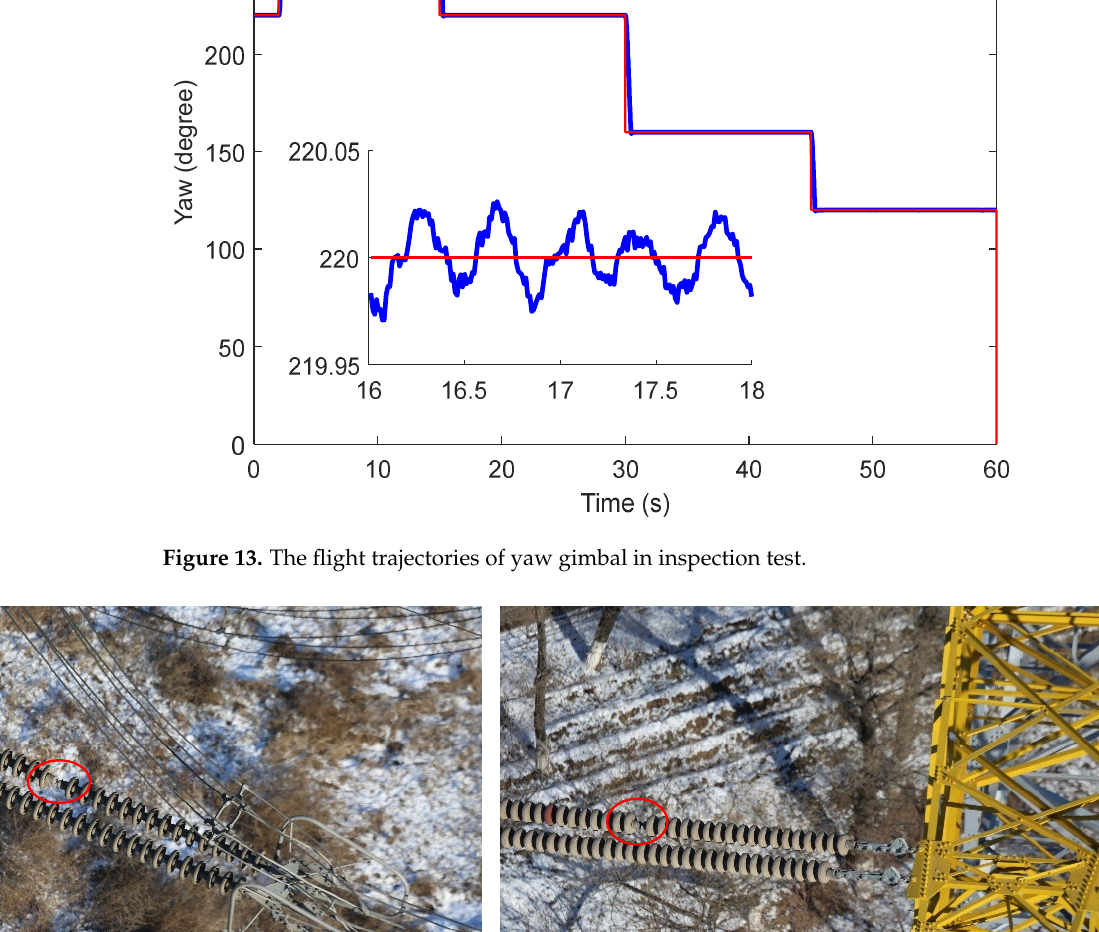
Figure 14. The located faults in the inspection.